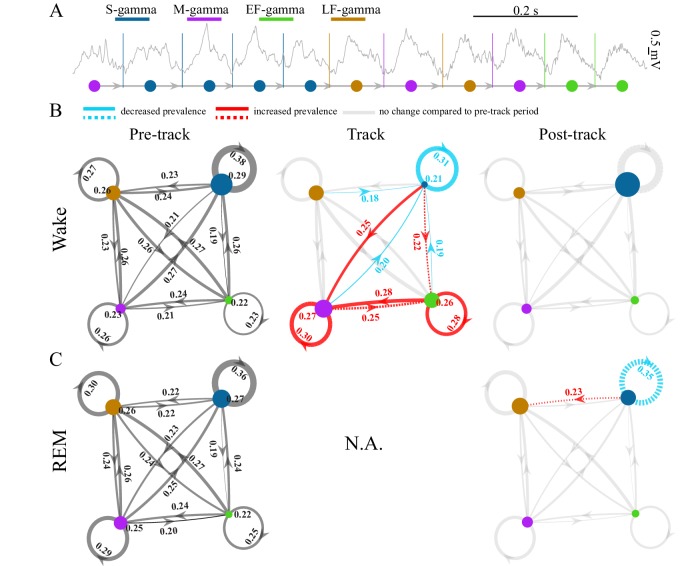
TG state transitions in awake and REM periods.(A) An example LFP trace is shown with each theta trough marked by vertical lines and an illustration of TG state transitions below. (B) Transition matrices and occurrence probabilities of the four states summarized during pre-maze (left), maze (middle) and post-maze (right) periods respectively for all rats during awake periods (n=8 sessions from 4 animals in Hc-11). Paired t-tests were performed across pre-, post-, and maze periods for 20 dynamic parameters including 16 (4 states × 4 states) transitions and 4 state occurrences. Only significant changes from the pre-maze period (paired t-test, q < 0.05, FDR correction for 60 comparisons) are highlighted and color coded in red (increased prevalence) and blue (decreased prevalence), less strict statistics are highlighted by a dashed line for q < 0.1. (C) The same as B for REM periods. Because there is no REM during maze exploration, pre and post maze comparisons were made. None of the 20 parameters reached significance (paired t-test, q > 0.05, FDR correction for 20 comparisons); S-gamma→S-gamma and S-gamma→LF-gamma are reduced and enhanced respectively by using less strict statistics (q < 0.1, FDR correction for 20 comparisons).